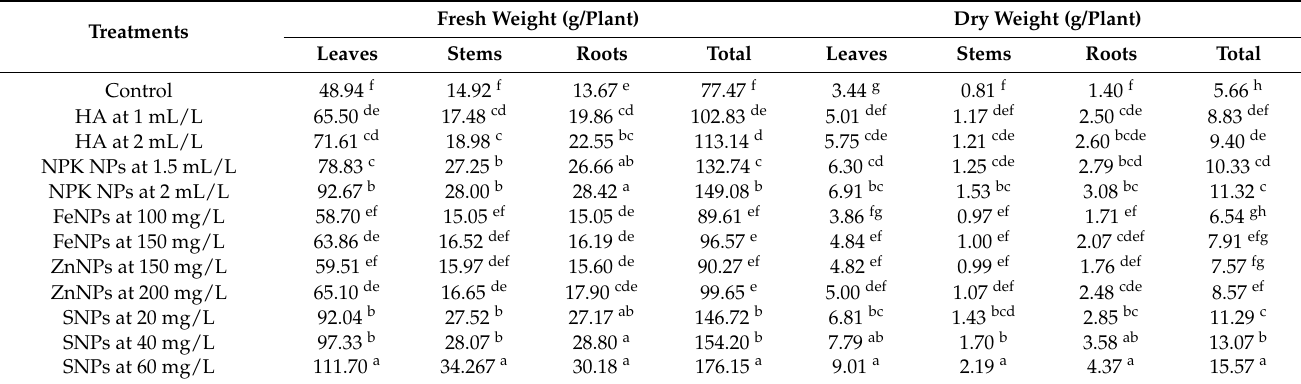
Table 4. Effect of nanoparticles and humic acid on fresh and dry weights of leaves, stems, and roots in Philodendron bipinnatifidum during 2019/2020 and 2020/2021